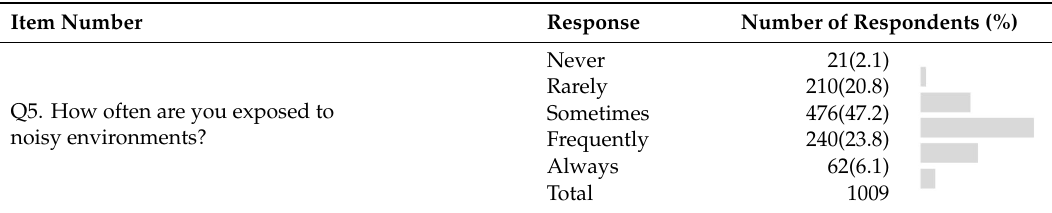
Table A1. Self-evaluation of one’s hearing status and personal experience of noise